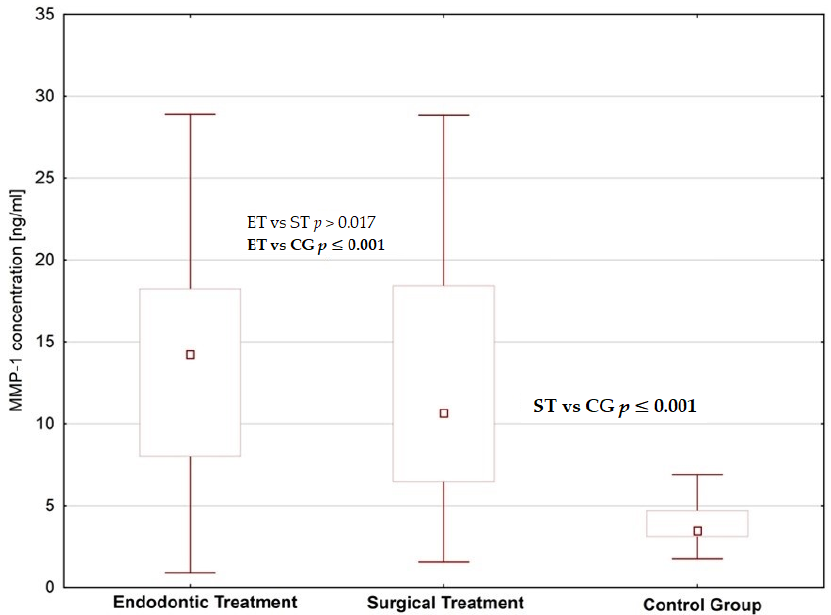
Figure 1. Saliva MMP-1 concentrations in patients planned for endodontic and surgical dental treatment in comparison to the control group.